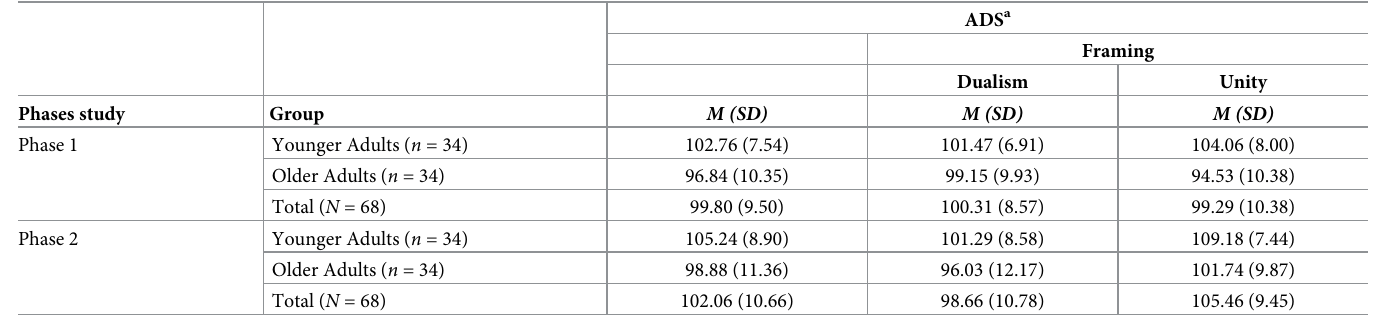
Table 2. Descriptive statistics on ADS.